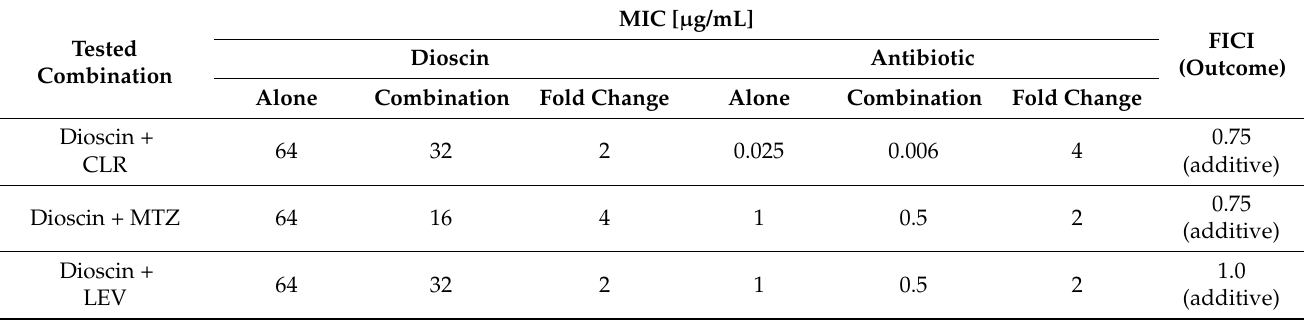
Table 3. Numerical values showing interactions between dioscin and the three classically used antibiotics (clarithromycin [CLR], metronidazole [MTZ], and levofloxacin [LEV]) in antibacterial activity against H. pylori J99. Interactions were determined using the checkerboard assay. MIC [ µ g/mL] FICI (Outcome)Dioscin